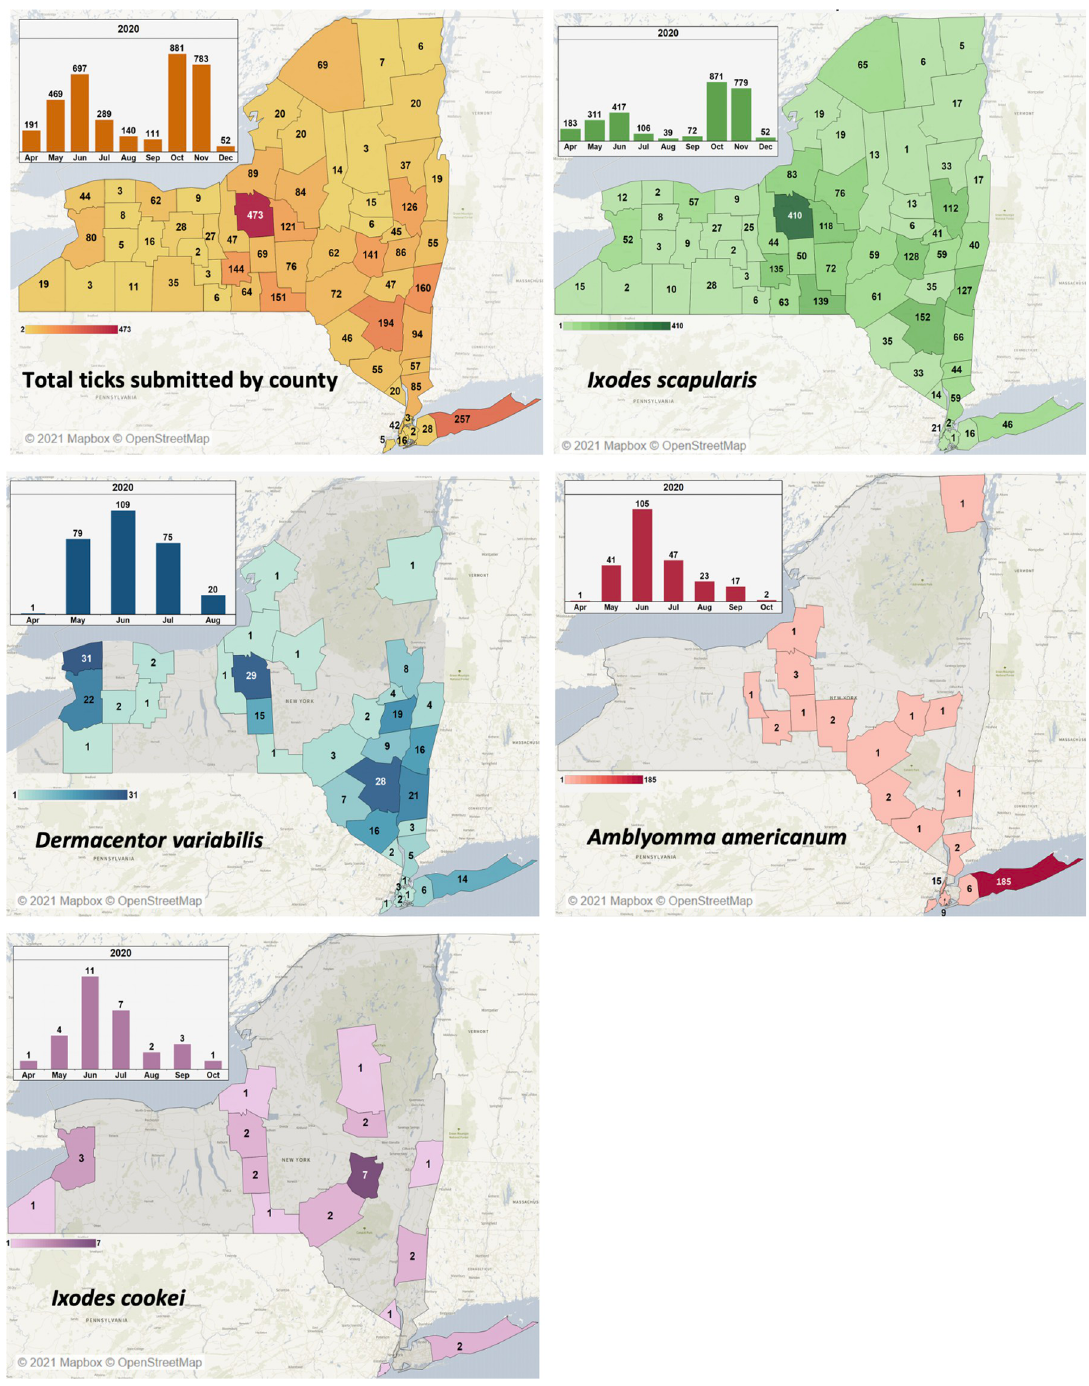
Fig 3. Distribution by county of the total ticks tested through the citizen science program. The spatial and temporal distribution of ticks indicates that I . scapularis is distributed throughout New York, with peak submissions during the spring and fall. D . variabilis , A . americanum , and I . cookei were submitted primarily during the summer and most often from the southern portion of the state, with D . variabilis additionally having a high submission rate in the west and A . americanum having its highest concentration in Suffolk County, Long Island. The base map for the images was obtained from Mapbox which is an open source map available at http://www.studio.